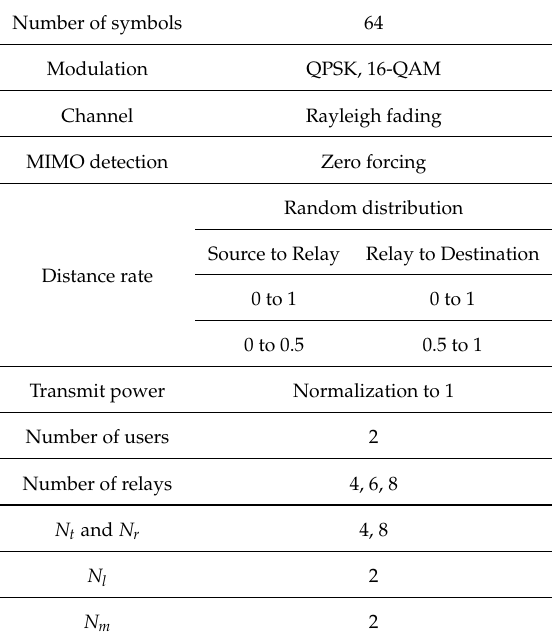
Table 1. Simulation